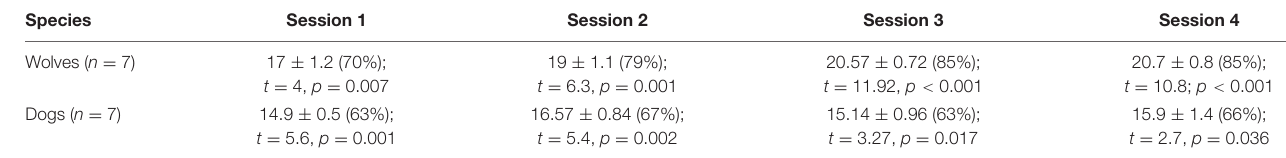
TABLE 2 | Wolves’ and dogs’ performance in comprehension